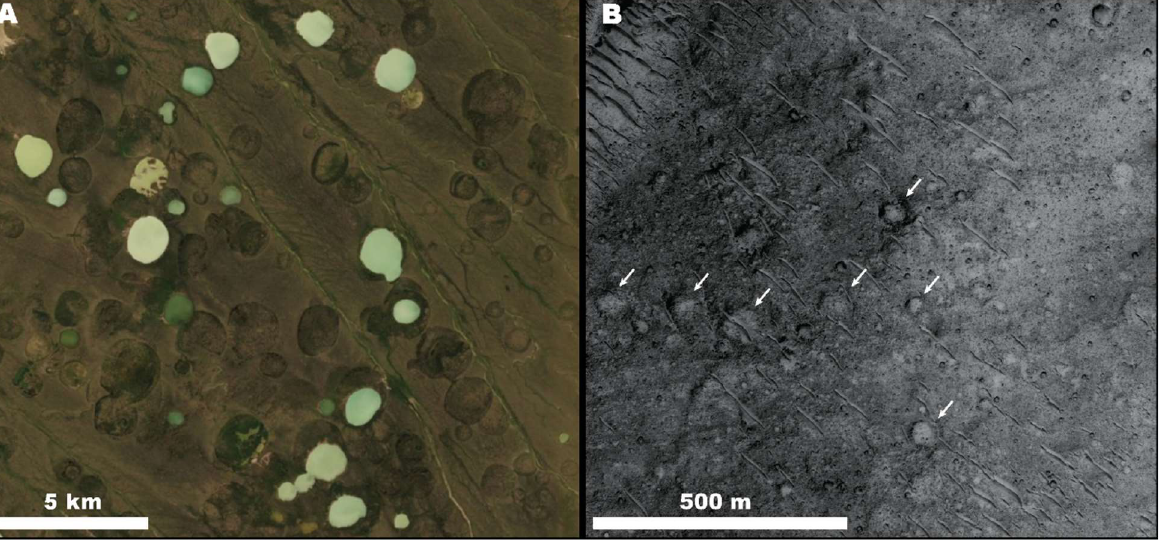
Figure 2. Kettle holes on Earth and Mars. ( A ) An example of the studied kettle hole features from Study Area C in Nunavut, Canada (see Figure 3 for location). ( B ) Degraded circular depressions observed in satellite images of Mars in the vicinity of Juventae Chasma where kettle holes on Mars have previously been interpreted [30]. HiRISE image ESP_024373_1895.